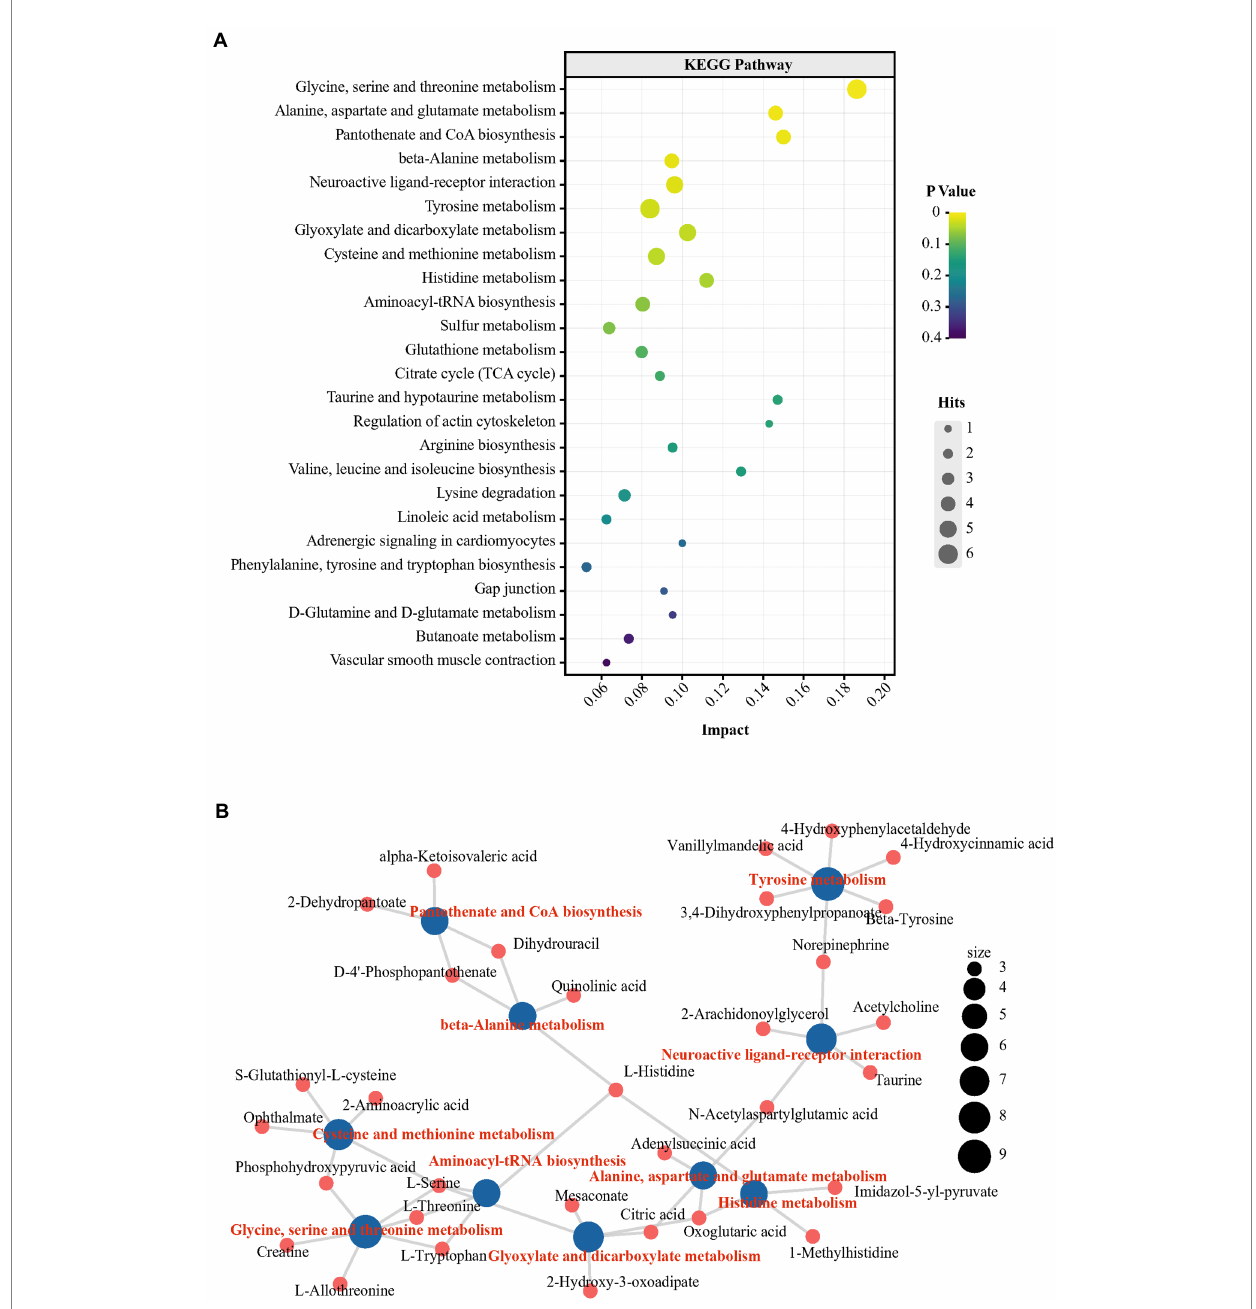
FIGURE 5 Changes in the metabolic profile in plasma obtained from FP birds. (A) Bubble chart using the top 25 KEGG pathways enriched by the differential metabolites in plasma; (B) Network plot using the top 10 KEGG pathways enriched from the differential metabolites in